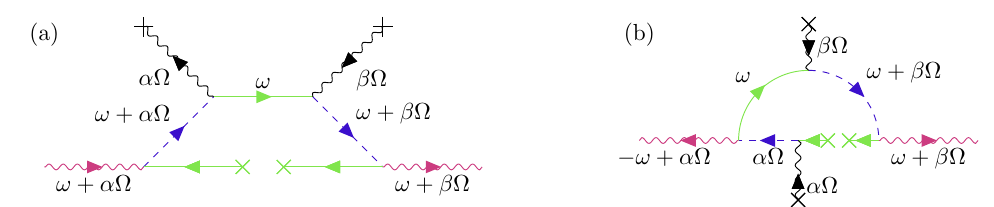
Figure 2: The scattering processes that determine the polarizability of a BEC driven by a PM laser. In these energy-momentum Feynman diagrams, the straight (wavy) lines represent propagation of a bare atom (photon) labeled by its frequency. The momentum / mode indices have been suppressed for brevity. Green solid lines repre- sent atoms in the electronic ground state and blue dashed ones atoms in the excited state. The purple wavy line indicate cavity photons. In addition, there are external sources, represented by lines ending in a cross. Those can be photons from a given sideband of the phase-modulated laser (see discussion in section 2.1), depicted as a black wavy line, or atoms from the BEC, depicted as solid green lines. Panel a) shows the normal process, whereas panel b) shows the anomalous process where the laser acts as a false